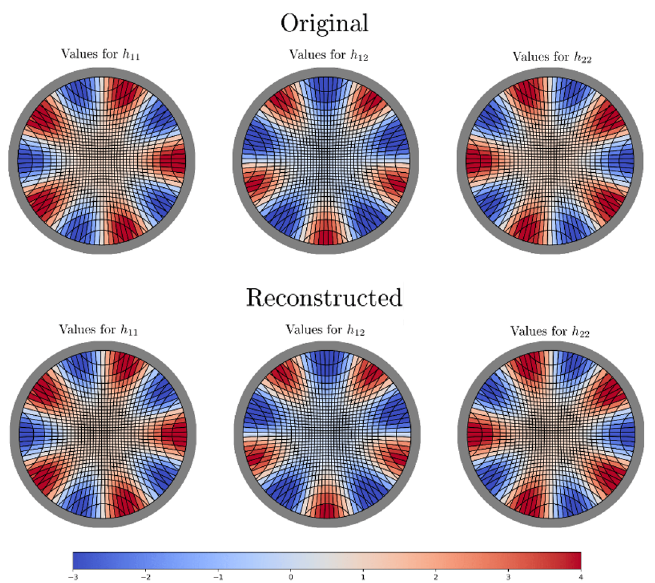
Figure 18. Top: Original bulk data generated with h 0 ( x, y ) = 1 / (1 + x 2 + y 2 ) and h | C ( θ ) = cos(5 θ ) . Bottom: The bulk data reconstructed after running the forward Radon transform to get boundary data. Visually, the two sets of data are identical. The relative error between the two are E bulk ≈ 0 . 0885 (relative error 0 . 01357 without boundary